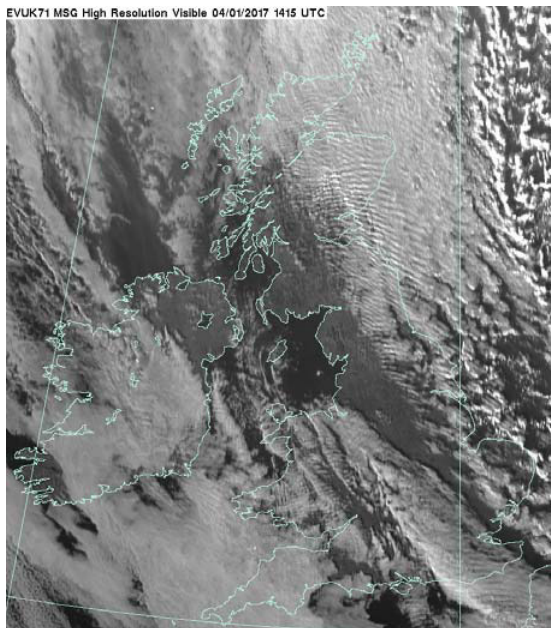
Figure 9. Satellite imagery (MSG) at14:15 on